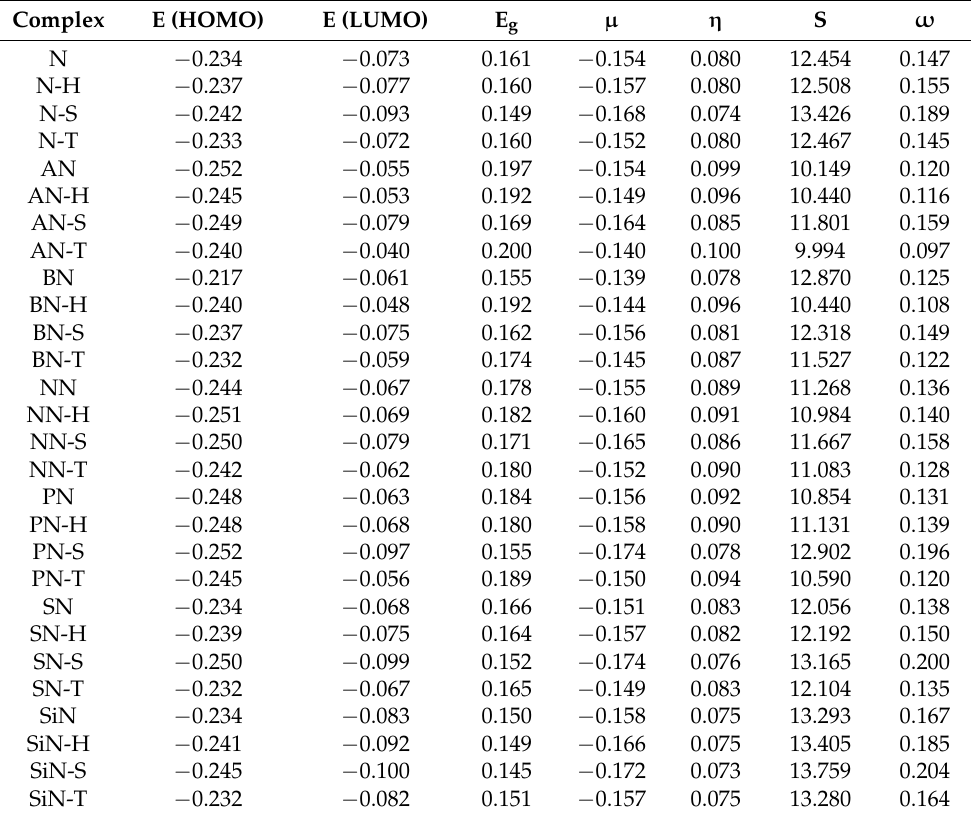
Table 5. Energies of HOMO and LUMO levels, energy gaps (E g ), chemical potential ( µ ), chemical hardness ( η ), global softness (S), and electrophilicity index ( ω ) for all structures (all energy values in